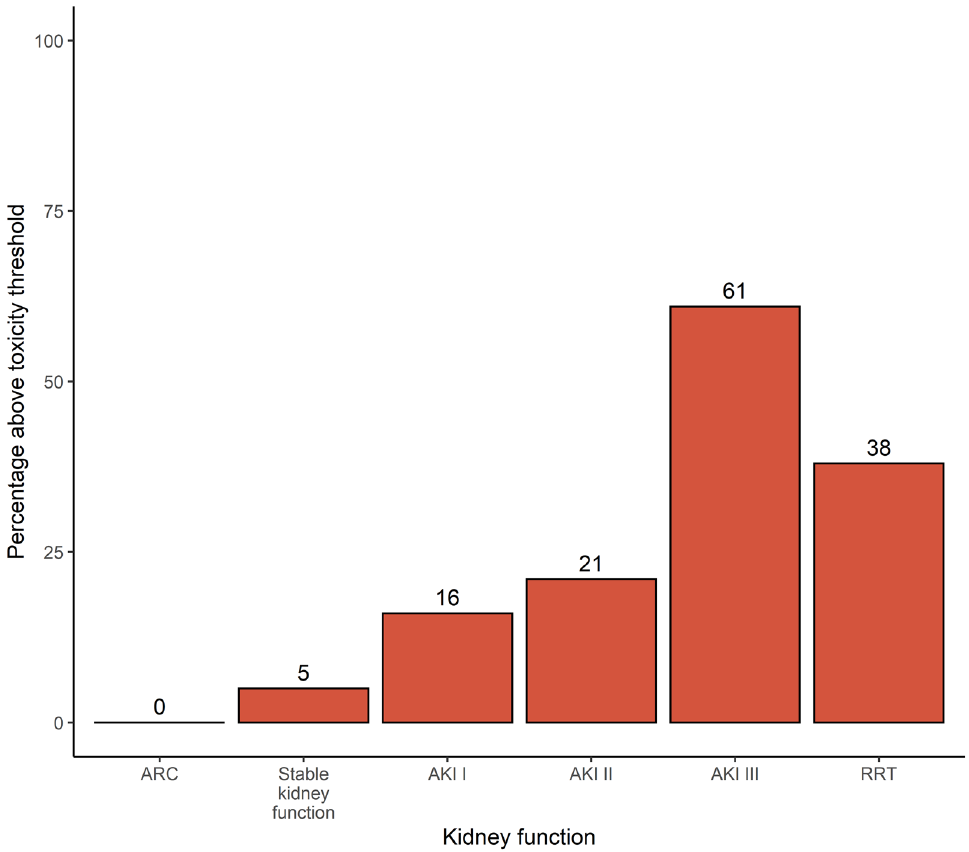
Fig. 4 Percentage of samples above the toxicity threshold for TZP according to renal function on day of